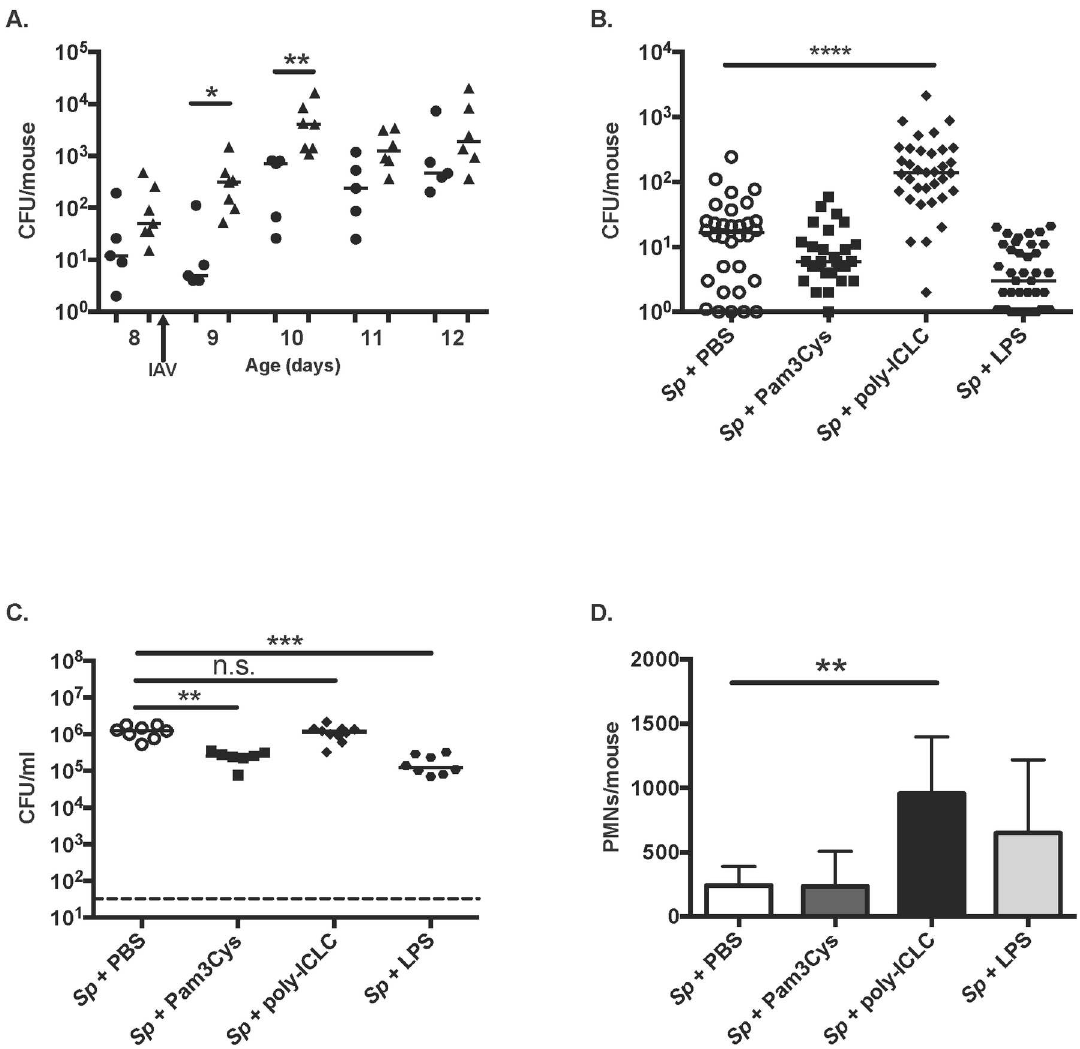
Fig 4. Increased pneumococcal shedding among tlr2 -/- mice or by daily treatment with Toll-like receptor (TLR) agonists. A. Wildtype (black circle) or tlr2 -/- pups (black triangle) were infected with strain P1547 on day 4, and IAV on day 8 of age as indicated.Daily nasal secretions were collected between day 8–12 of age. Each dot represents a single mouse. Statistical differences between the two groups in each day were evaluatedby using Mann-Whitney U test. * p < 0.05 and ** p < 0.01. B, C, D. Wildtype pups were infected with strain P1547 on day 4, and given a daily IN dose of PBS, Pam3Cys, poly-ICLC or LPS between days 8 and 12. Statistical analysesbetween four groups were performed by Kruskal-Wallis test (Dunn’s multiple comparison test). ** p < 0.01, *** p < 0.001, **** p < 0.0001and n.s. not significant. B. Shedding(combined values from days 9 through12) was compared by quantitativeculture of secretions. C. Colonization was compared